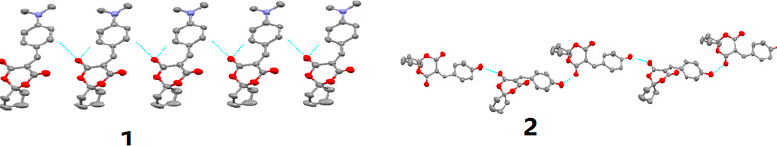
Figure 3. Hydrogen bonds and intermolecular interactions of 1 and 2.